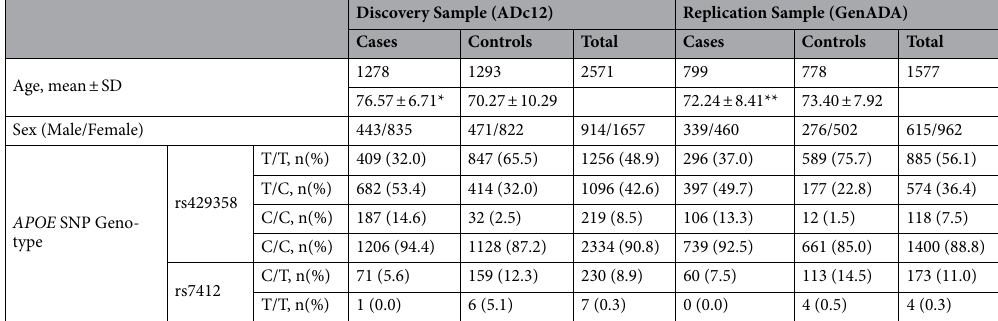
Table 2. Demographic characteristics of the target data (ADc12 and GenADA) with APOE SNP genotyping. Both discovery (ADc12) and replication (GenADA) samples were downloaded from dbGaP. Age, mean ± SD. For each case, the “Age” was the age at onset (AAO). For each control, the “Age” was the age at examination (AAE). * p = 5.97 × 10 −71 when AAO compared to AAE in the discovery sample. ** p = 4.94 × 10 −3 when AAO compared to AAE in the replication